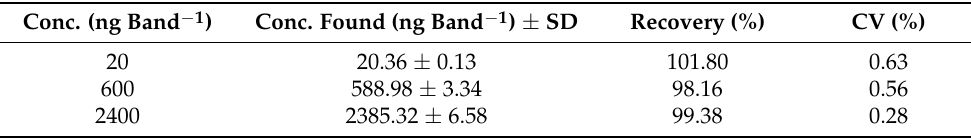
The results for the accuracy analysis for the present analytical method are listed in Table 3. The % recovery of HDQ for the present RP-HPTLC method was determined as 101.80%, 98.16%, and 99.38% at LQC, MQC, and HQC, respectively. The high values of % recoveries indicated the accuracy of the present RP-HPTLC method for HDQ analysis in the CWCs. Table 3. Measurement of accuracy of HDQ for ecologically sustainable HPTLC method (mean ± SD; n = 6).